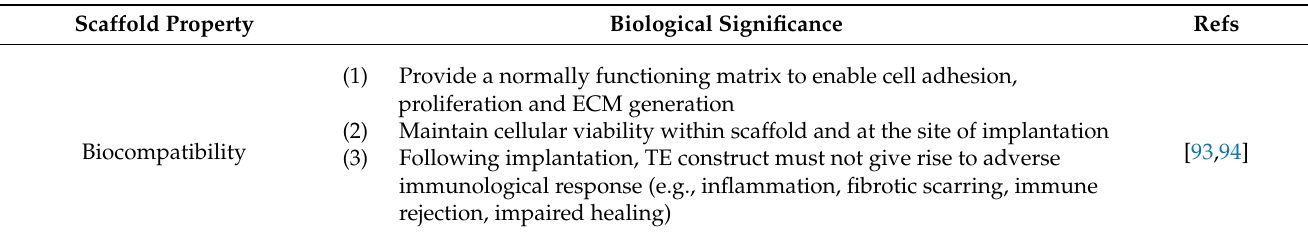
Table 3. Desirable characteristics of a tissue-engineered